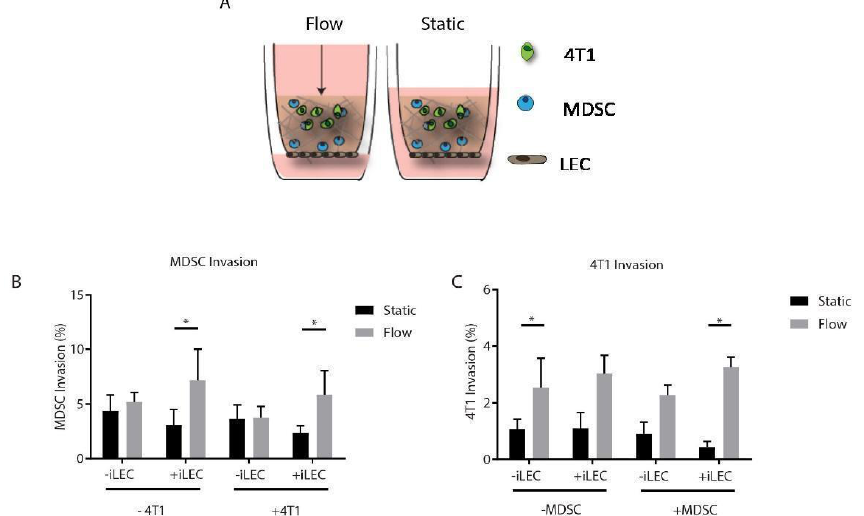
Figure 4. Lymphatic endothelial cells and flow coordinate in enhancing migration of MDSCs and 4T1s. ( A ) Schematic of 3D cell culture model with collagen − BME hydrogel and 4T1s, MDSCs, and LECs under flow (left) and static (right) conditions. ( B ) Quantification of GR1+ MDSC percent migration in the presence of both iLECs and 4T1 cells under static and flow conditions ( n = 3). ( C ) Quantification of 4T1 percent migration in the presence of iLECs and MDSCs ( n = 3). Data and error bars represent mean ± SEM (*, p < 0.05) .